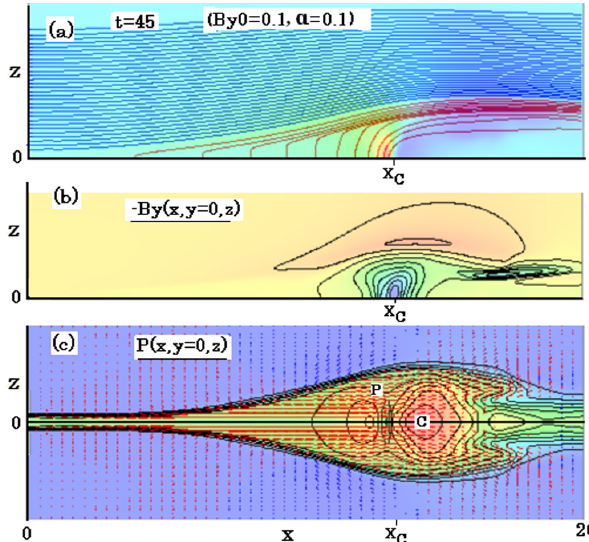
Fig. 5. (a) Magnetic field lines passing through the x- and z-axes, projected onto the y = 0 [ (x,z) ] plane, with the distribution of B z in color, (b) distribution of − B y with contour interval of 0 . 1 and (c) plasma pressure distribution with contour interval of 0 . 15 and plasma flow vectors, in the y = 0 plane at t = 45 for the case of B y0 = 0 . 1 and α = 0 . 1, where X C is the plasmoid center and the regions P and C are indicated.